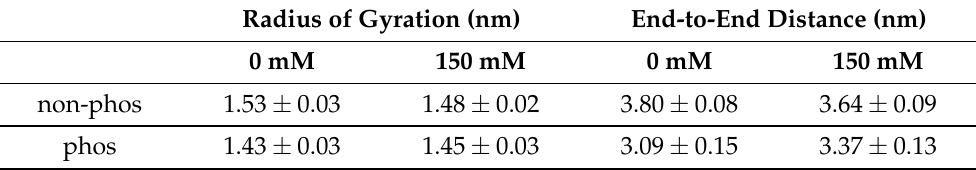
Table 5. Average radius of gyration and end-to-end distance of the non-phosphorylated (non- phos) and phosphorylated (phos) bCPP in the presence of 0 and 150 mM NaCl. The data for the phosphorylated peptide are previously published in